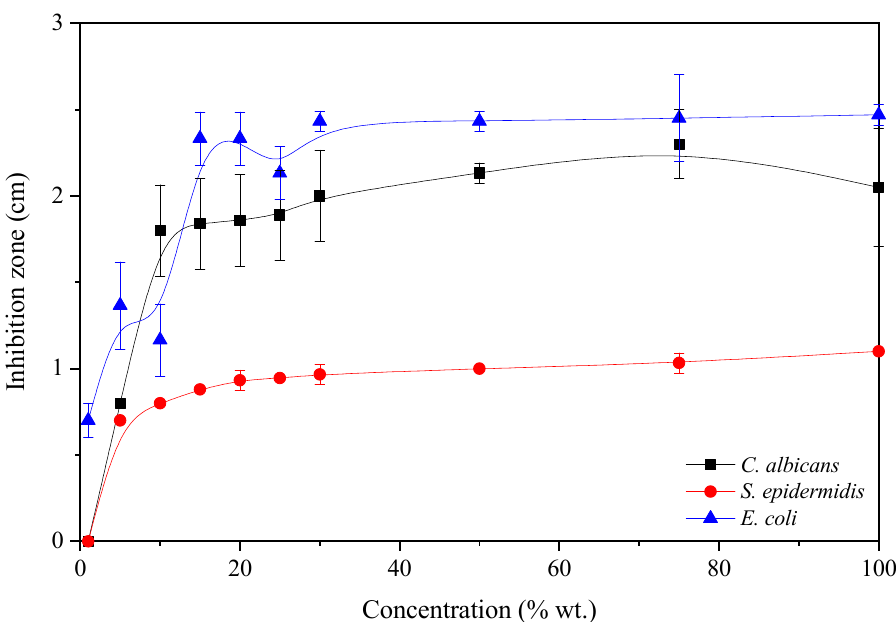
Figure 7. The impact of concentrations of the eugenol for microbial growth inhibition zone.